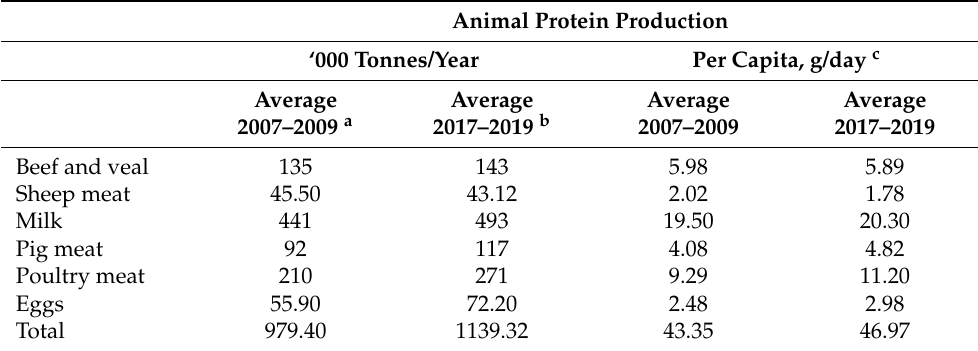
Table 2. Estimated UK home-fed production of edible animal protein (excluding fish), 2008 and